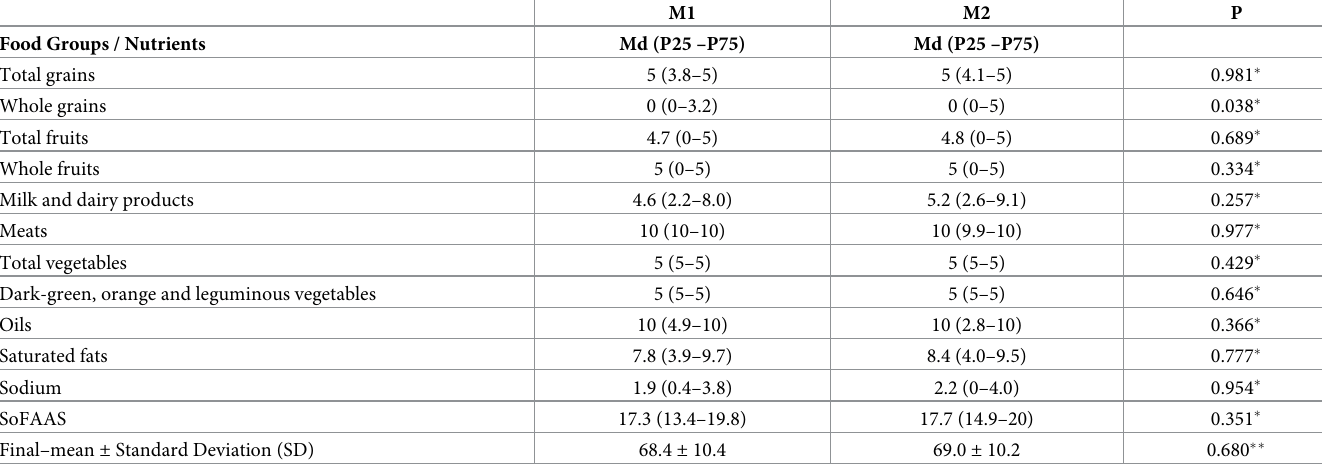
Table 1. Comparison of Brazilian Healthy Eating Index—Revised (BHEI-R) scores between evaluations at M1 and M2 in patients with metabolic syndrome, Porto Alegre, Brazil (n = 63).